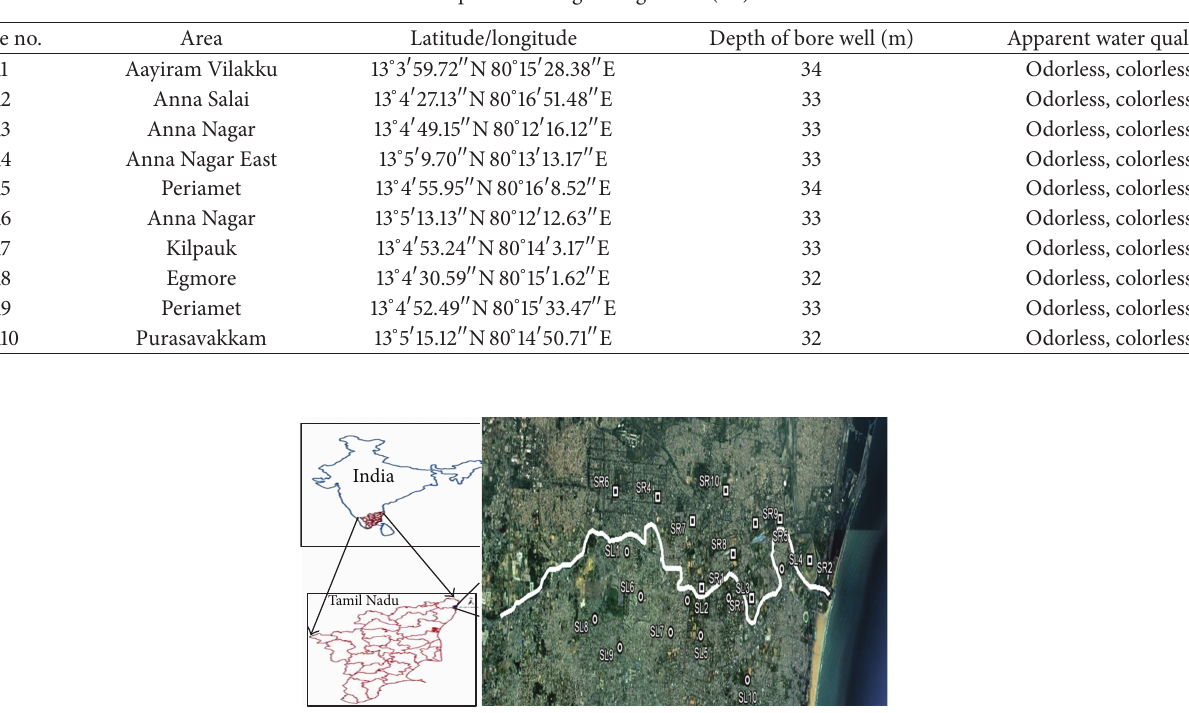
Table 2: Detail of sample sites along the right side (SR) of the Cooum river.